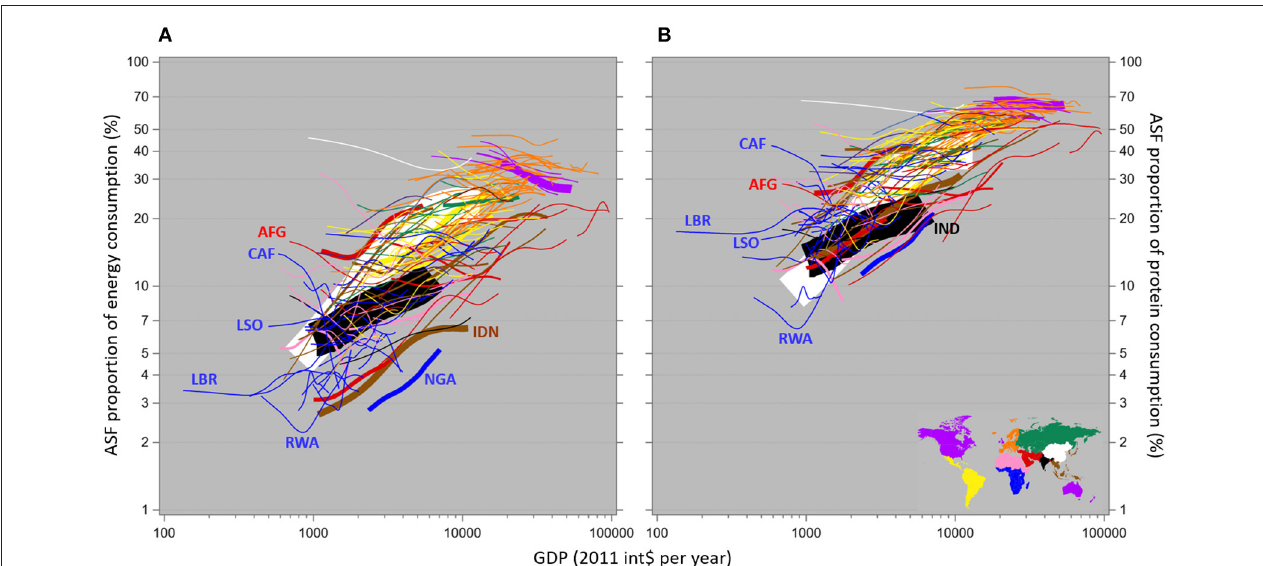
FIGURE 3 | Country-specific spline interpolation plots of the proportions of daily energy (A) and protein (B) consumption that are based on animal source foods, in relation to income and not adjusted for any non-income factors. The width of each line reflects the country’s population size in 2016. Note that both axes are